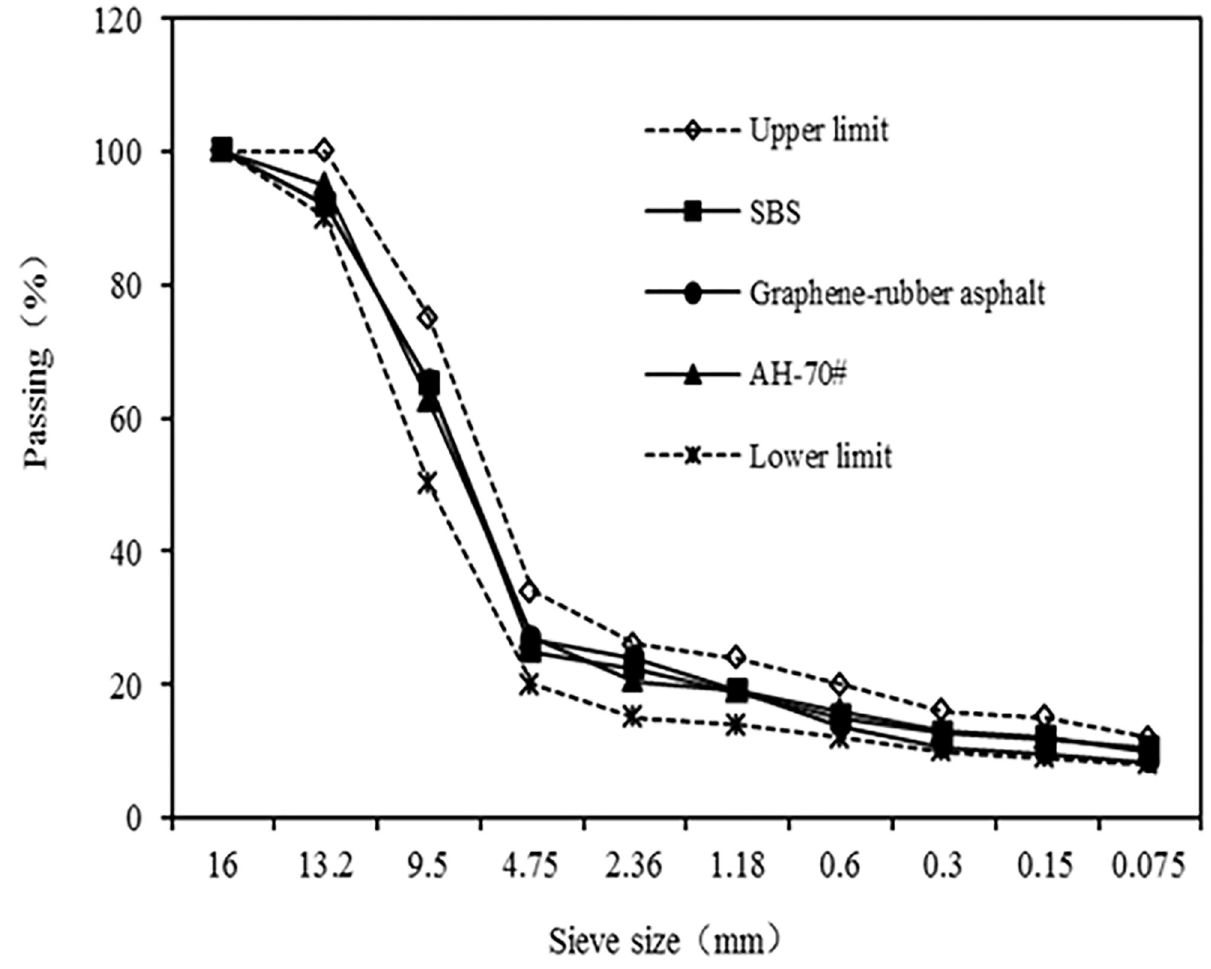
Fig 3. The gradation type of mineral aggregate of asphalt